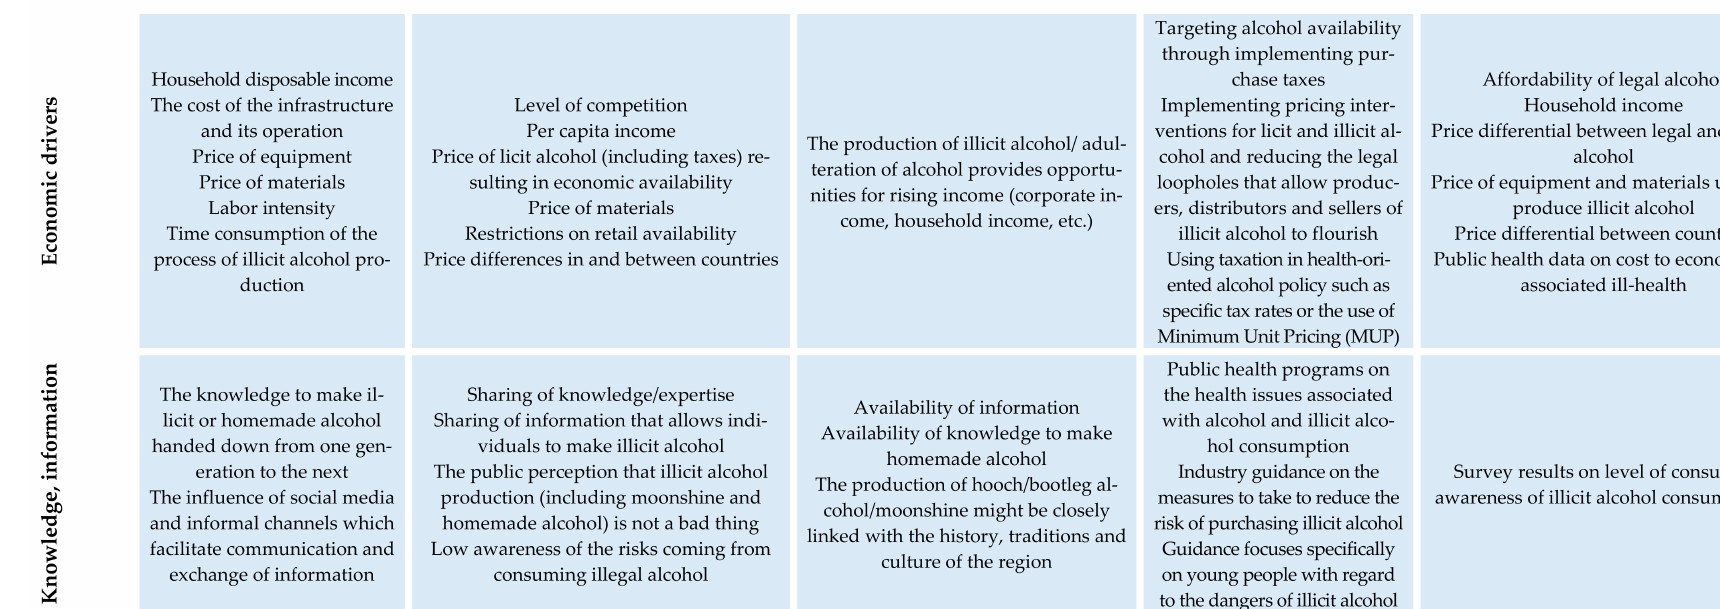
Figure 1. Drivers of illicit alcohol production, distribution, sale and consumption, policy measures and activity-related signals (Adapted from